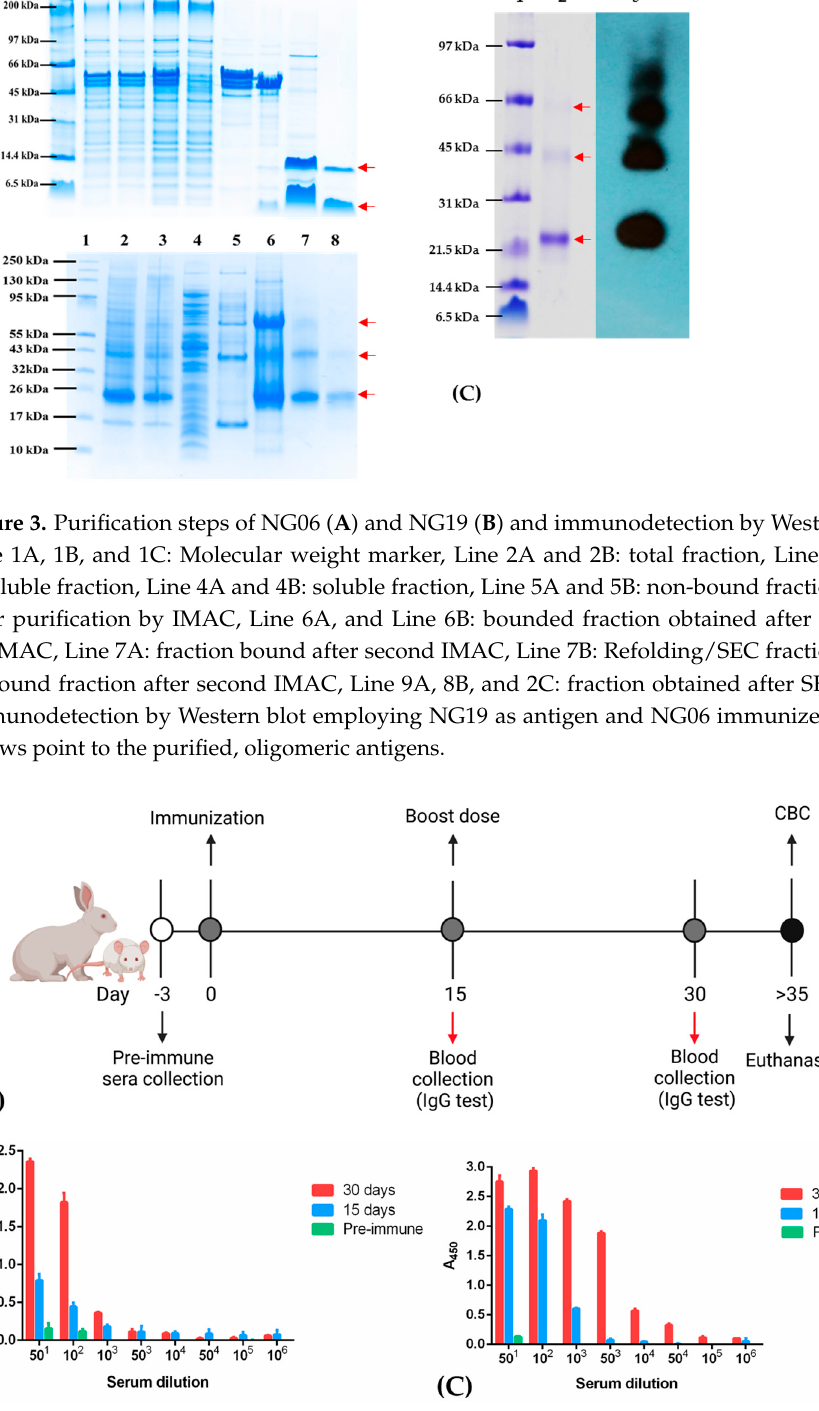
Figure 4. NG06 and NG19 proteins elicit immune responses. ( A ) Scheme of animal immunization with recombinant antigens. ( B , C ) Indirect ELISA titration of pre–immune and hyperimmune rabbit sera using antigens NG06 ( B ) and NG19 ( C ). CBC: Complete blood